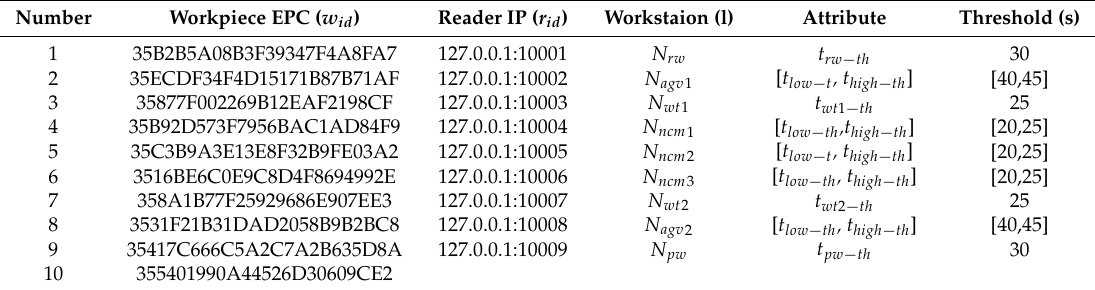
Table 5. Workpiece EPCs, reader IPs and attribute threshold values.